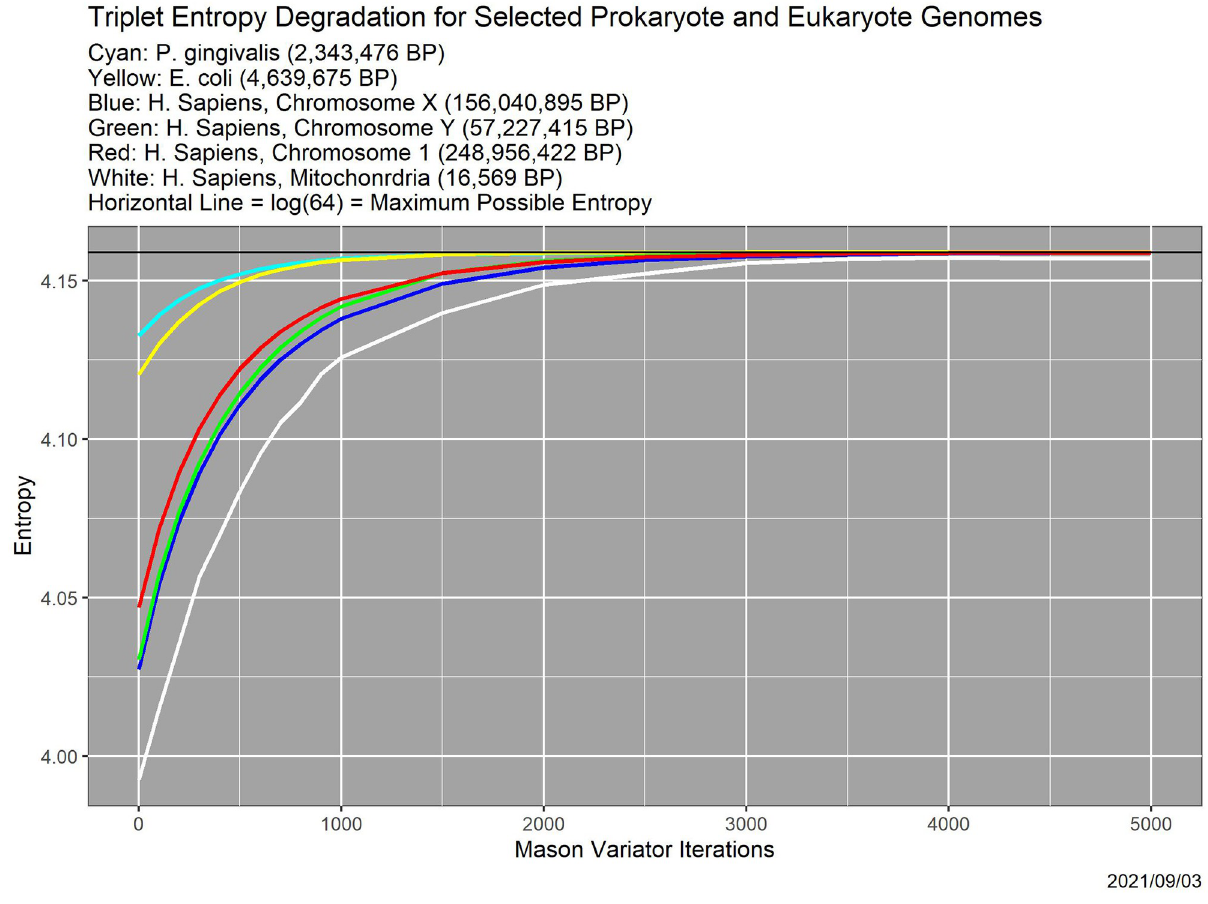
Fig 10. Entropy as a function of Mason_variator iterations, for selected prokaryote and eukaryote genomes. Included are two bacterial genomes— P. gingivalis and E. coli , three human chromosomes—1, X and Y, and human mitochondrial DNA.